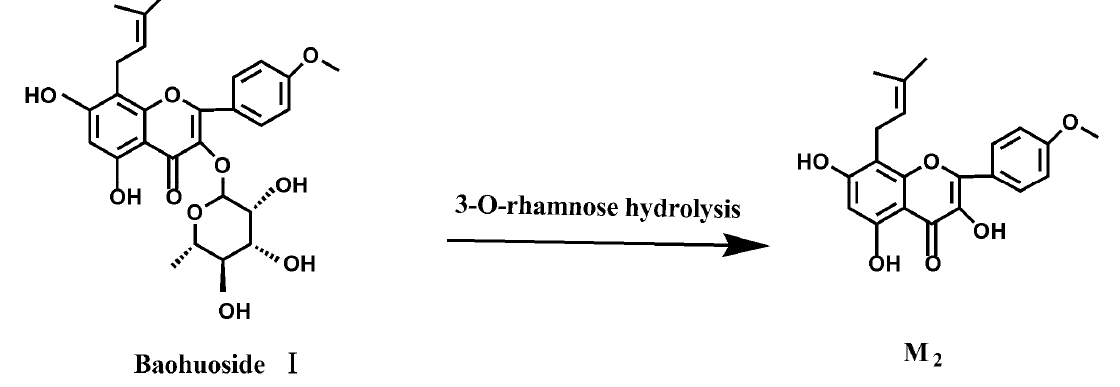
Figure 15. The metabolic pathway of baohuoside I in intestinal flora and enzyme of